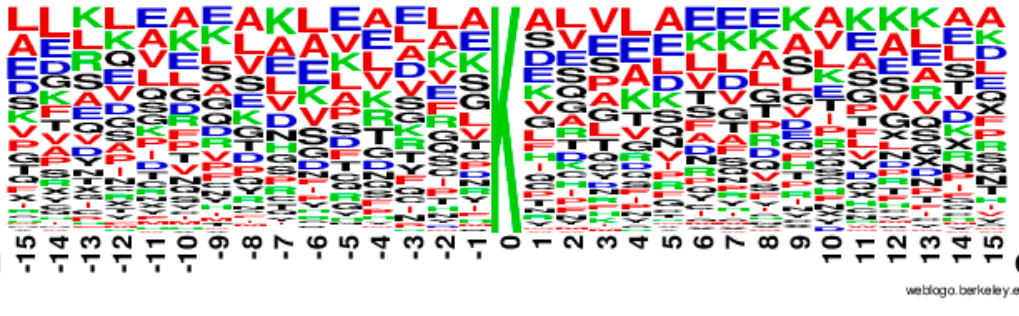
Figure 3. The sequence logo of lysine glycation sites.